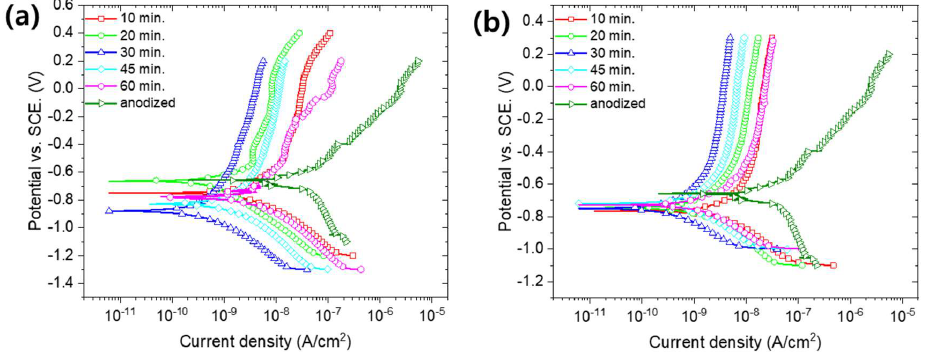
Figure 2. Surface SEM images of nanoporous anodic aluminum oxide with ( a ) nickel acetate hot sealing (NAHS) and ( b ) nickel fluoride cold sealing (NFCS) for 10 min, 30 min and 60 min.